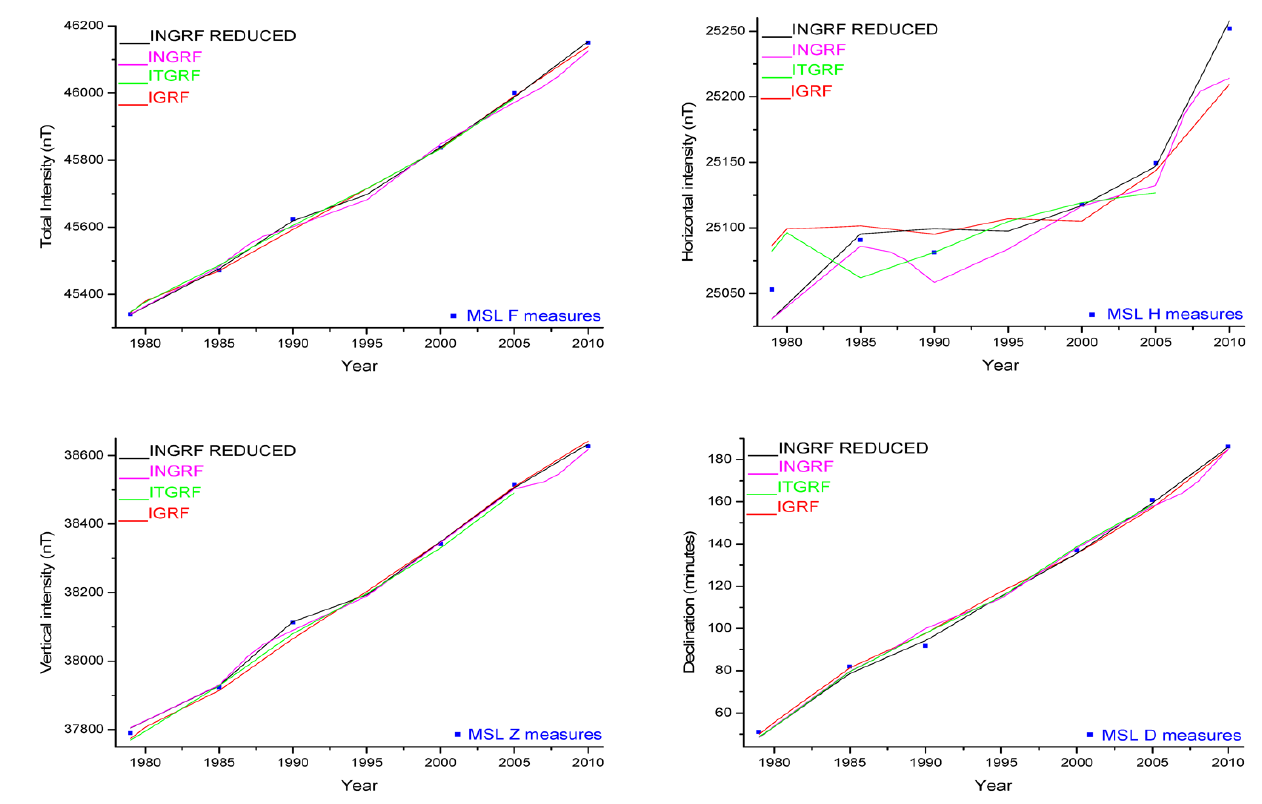
Figure 11. Measures of F, H, Z, D at MSL station (squares) together with the values predicted by various models (coloured